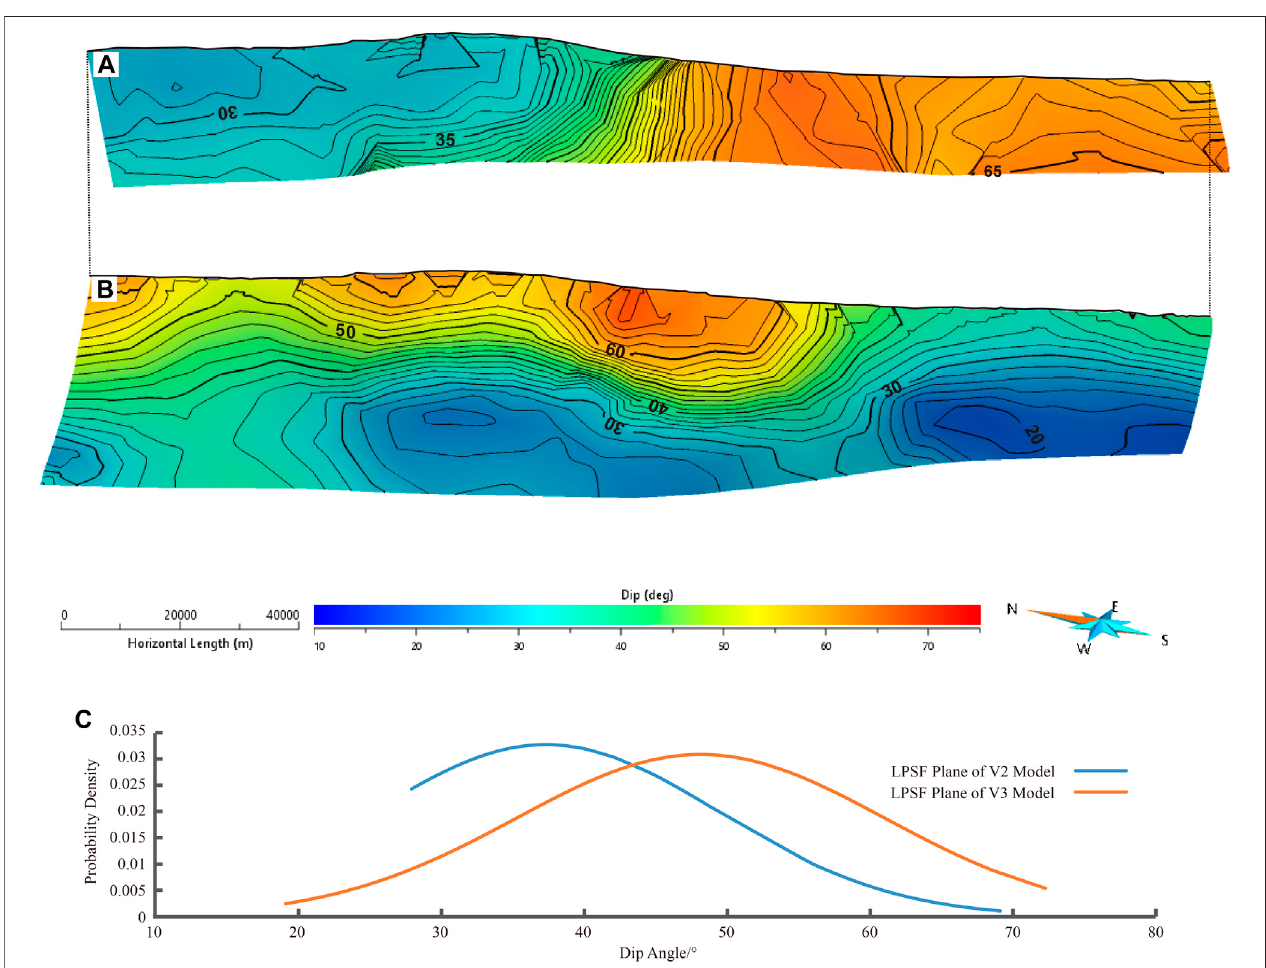
FIGURE 10 | (A) Dip angles of the Liupanshan fault planes in the V2 model; (B) Dip angles of the Liupanshan fault planes in the V3 model; (C) Normal distribution statistics of dip angles of the Liupanshan fault planes in the V2 model and V3 model. The top of the fault planes is outlined with black lines, the colors of fault planes represent the change of dip angles, and there are dip angle contour lines on the fault planes in (A,B) .